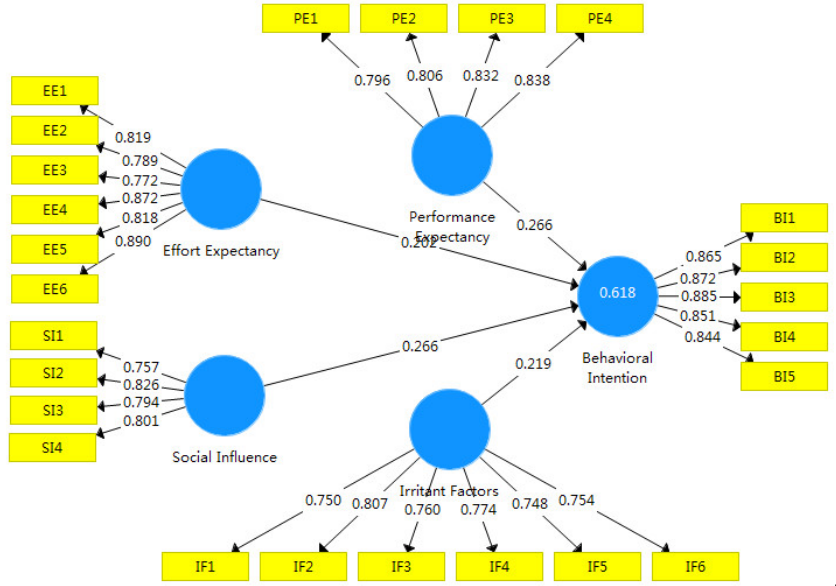
Figure 3. Extended UTAUT model. Figure 2. Original UTAUT model.